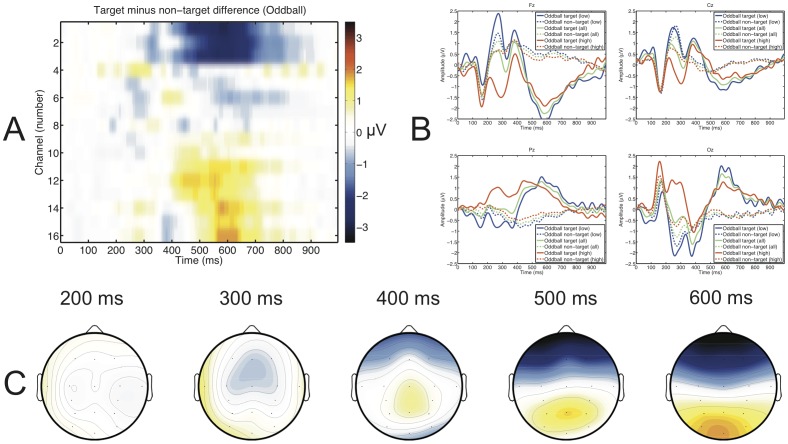
The average amplitude across all participants of the response to the auditory oddball is shown as the full spatio-temporal feature matrix (EEG channels are in the sequence given in the data acquisition section) of the target non-target difference (A).Time course at Fz, Cz, Pz and Oz of the averaged ERP are shown for high aptitude (red), low aptitude (blue) and all users (green) for targets (continuous lines) and non-targets (dashed lines; B). Topographic distribution (the scale is the same as in A) of the target non-target difference at 200, 300, 400, 500 and 600 ms (C).